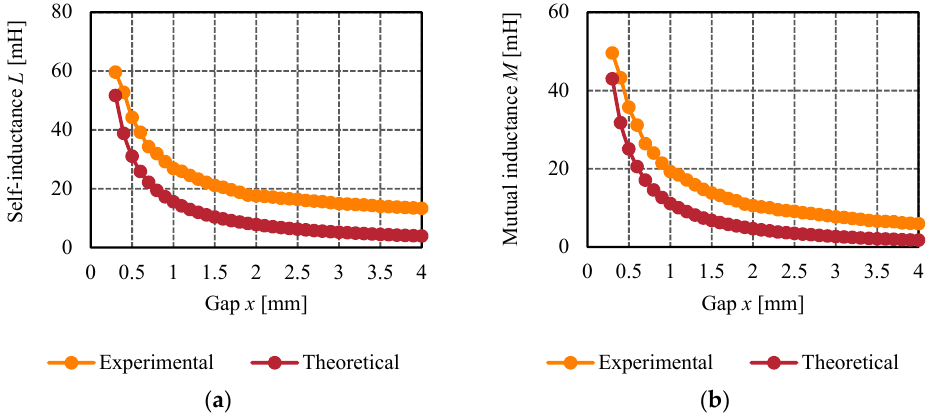
Figure 8. Comparison of characteristics curve between experimental and theoretical value: ( a ) self- Figure8. Comparisonofcharacteristicscurvebetweenexperimentalandtheoreticalvalue: ( a )self-inductance; inductance; ( b ) mutual inductance. ( b ) mutual